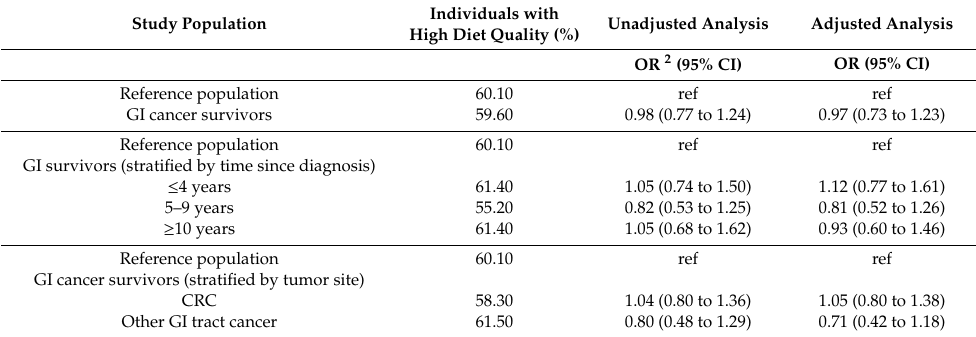
Table 2. Association between gastrointestinal (GI) cancer survivors and high diet quality 1 , unadjusted and adjusted analysis, stratified by time since diagnosis and tumor